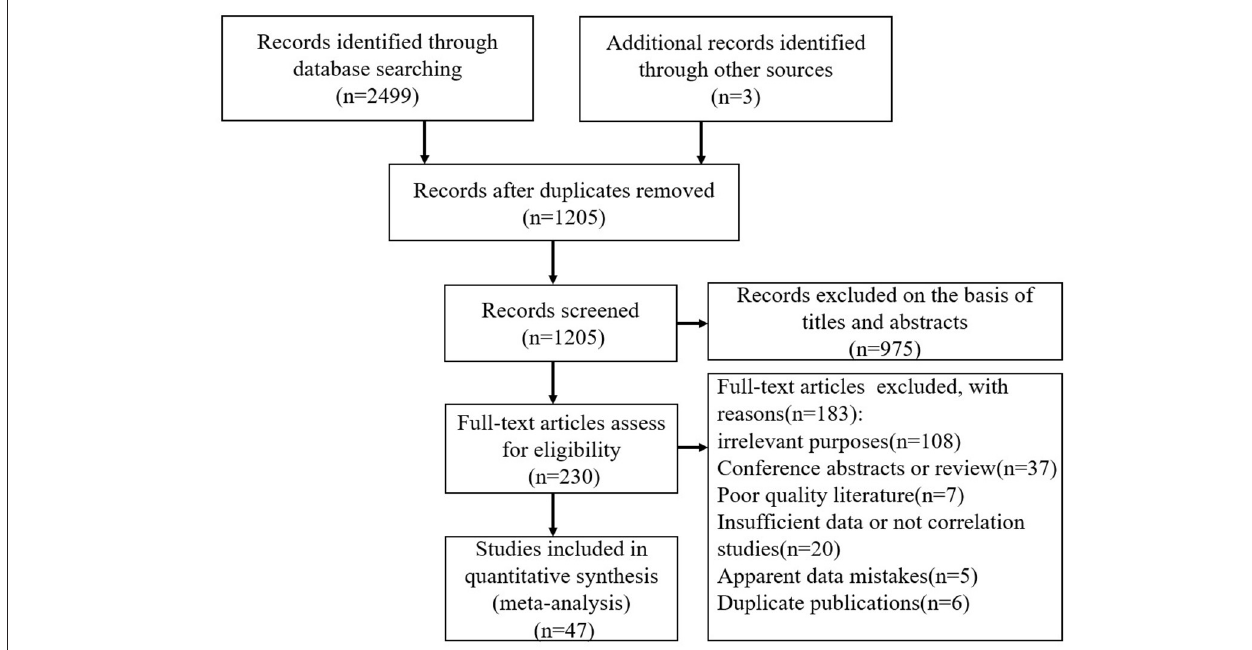
FIGURE 1 | The flow chart of the study selection